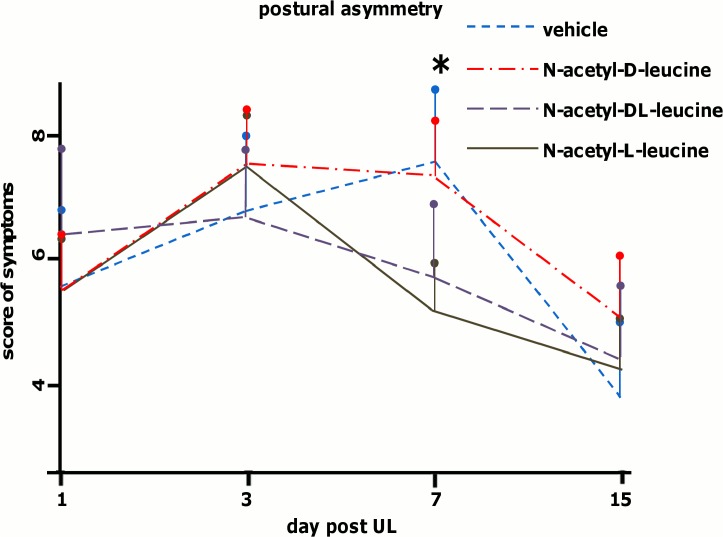
Postural imbalance scores after unilateral labyrinthectomy in the control and treatment groups.Sham treatment (vehicle), N-acetyl-DL-leucine, N-acetyl-L-leucine or N-acetyl-D-leucine (24 mg per rat each) was administered i.v. on days 1, 2 and 3 (six animals in each group). Postural imbalance scores were analyzed in all groups on days 1, 3, 7 and 15. Postural imbalance scores were significantly decreased in the N-acetyl-DL-leucine- (p < 0.03) and N-acetyl-L-leucine-group (p < 0.01) on day 7. Values are depicted as mean, the standard deviation as error bars. Significant values (DL-group vs. control and L-group vs. vehicle group on day 7) are marked with an asterisk.